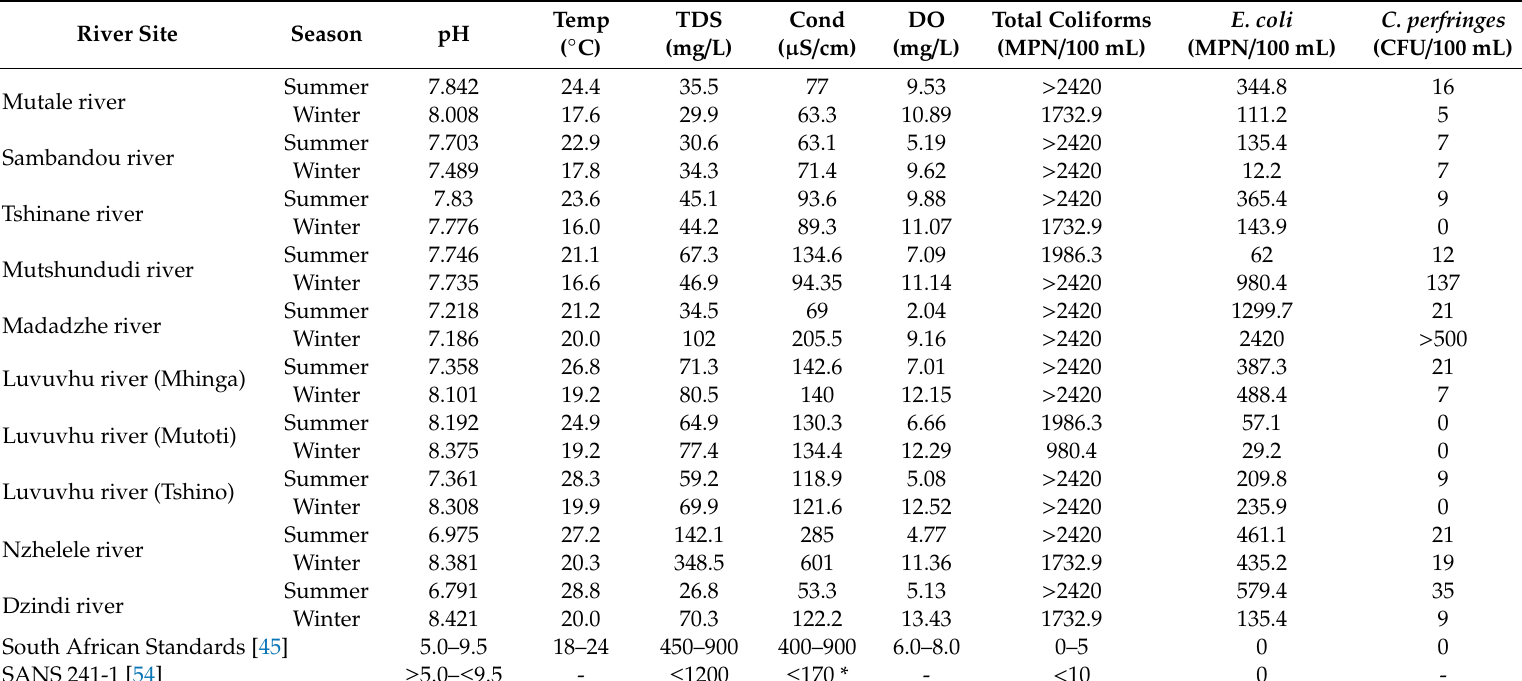
Table 2. Physical parameters and indicator bacteria detected in eight rivers in the Limpopo